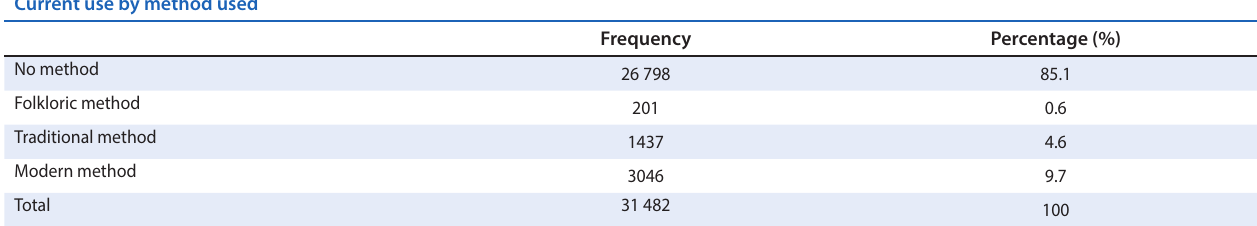
Table 1: Frequency of women on family planning Current use by method used